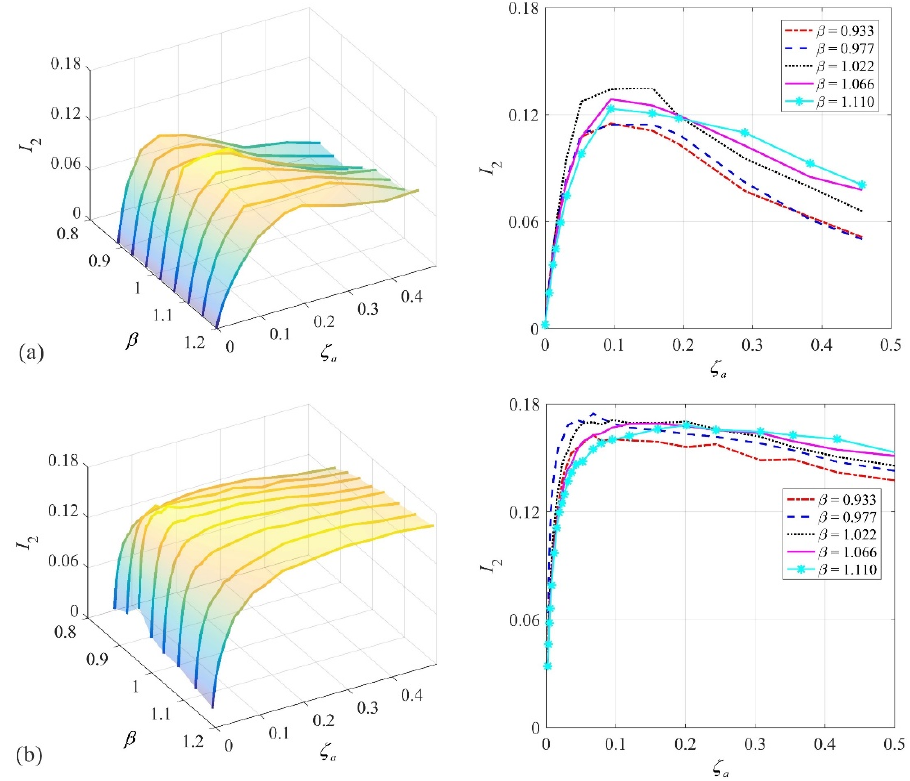
Figure 14. 3D and 2D plots of I 2 with µ = 0.050: ( a ) experimental result; ( b ) simulation result.